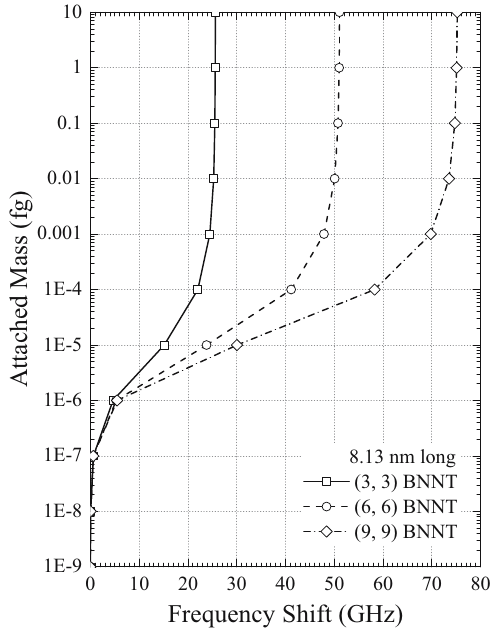
Figure 6: Frequency shifts for ( 3,3 ) , ( 6,6 ) , and ( 9,9 ) cantilevered SW - BNNT with length 6.09 nm for di ff erent attached masses.